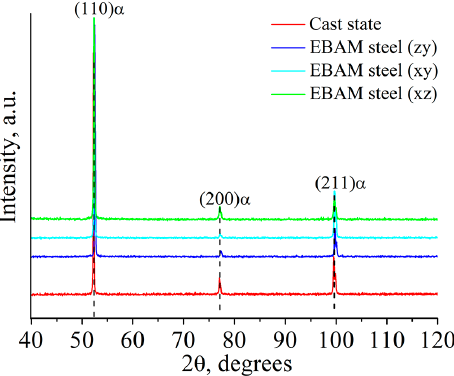
Figure 3. XRD patterns obtained for low ‐ carbon steel in the cast state and after the EBAM process.